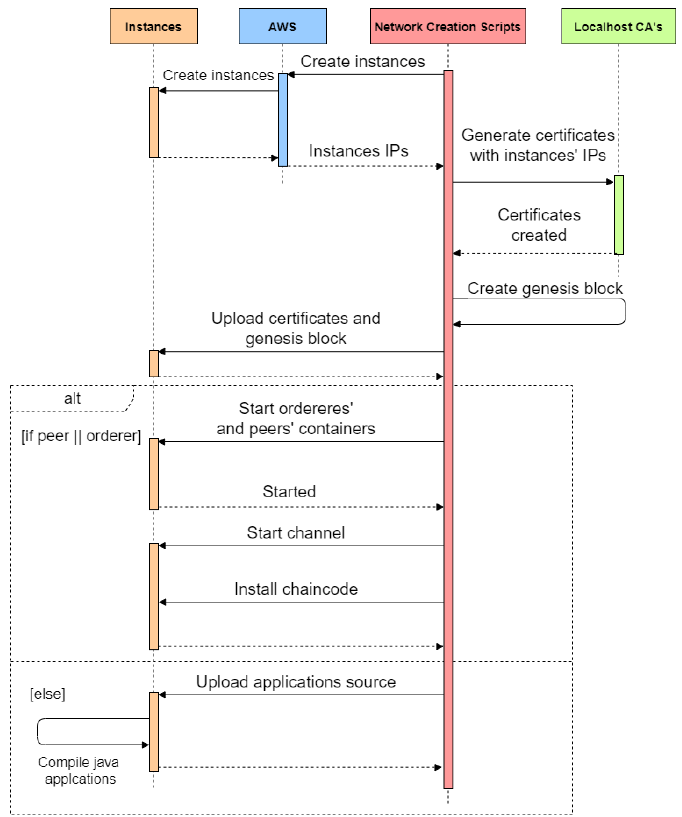
Figure 4. AWS deploy high-level